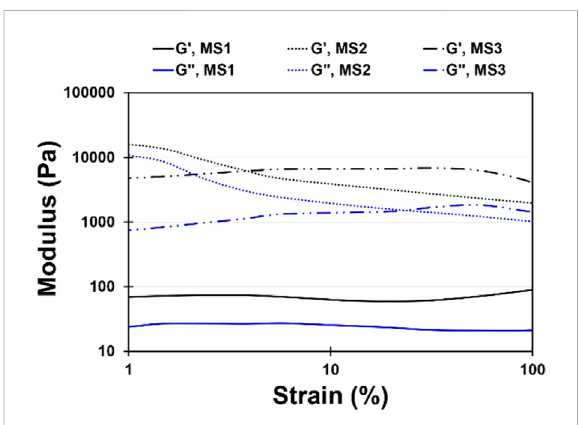
FIGURE 3 Strain sweep diagram at a constant frequency ( ω ) of 1 rad/s andstrainrangeof1 < γ < 100%forMS1,MS2,andMS3hydrogelsat constant temperature (37 ° C ± 0.5 °